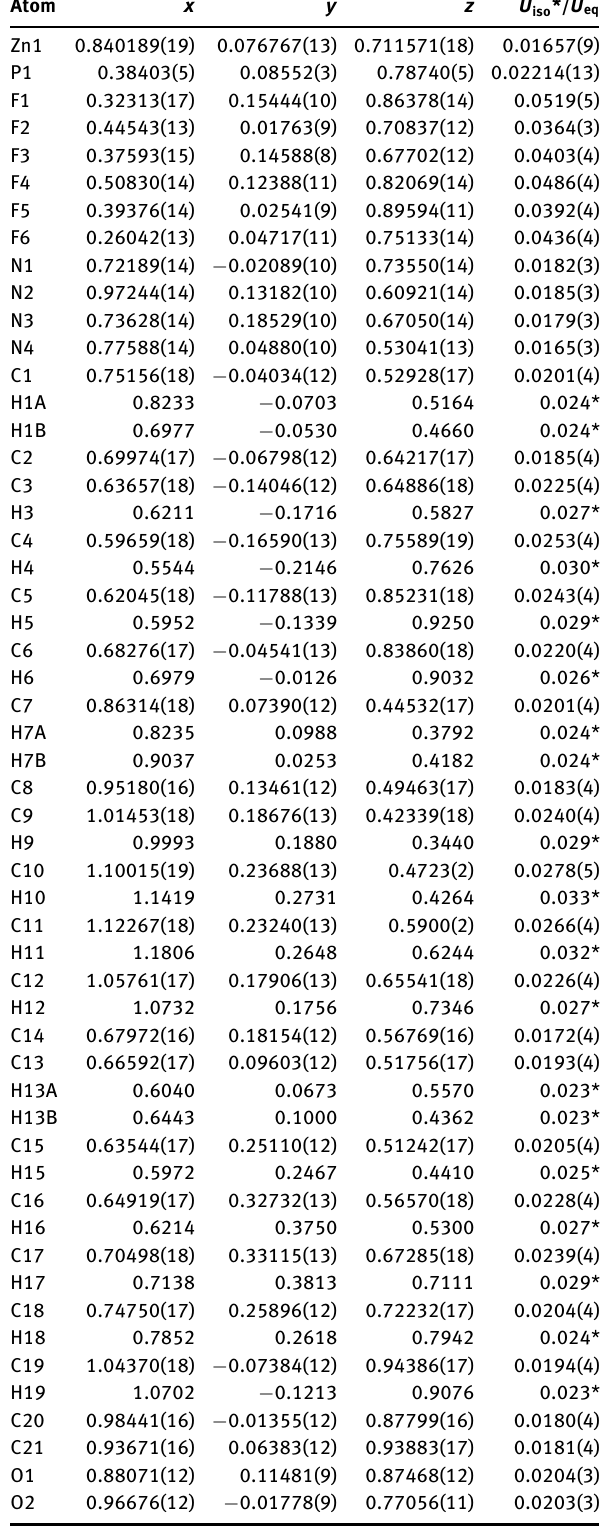
Table 2: Fractional atomic coordinates and isotropic or equivalent isotropic displacement parameters (Å 2